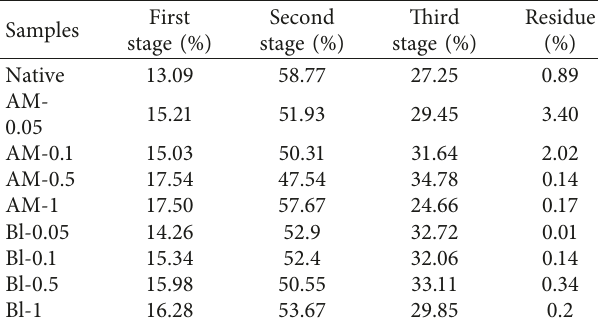
Figure 3: Distribution of the scattering intensity I (%) with respect to the hydrodynamic radius of the particles in 0.5g · l − 1 solution of starches in DMSO. Measurement temperature: 25 ° C. Table 4: Mass loss percentages of potato native and treatment starches, calculated by